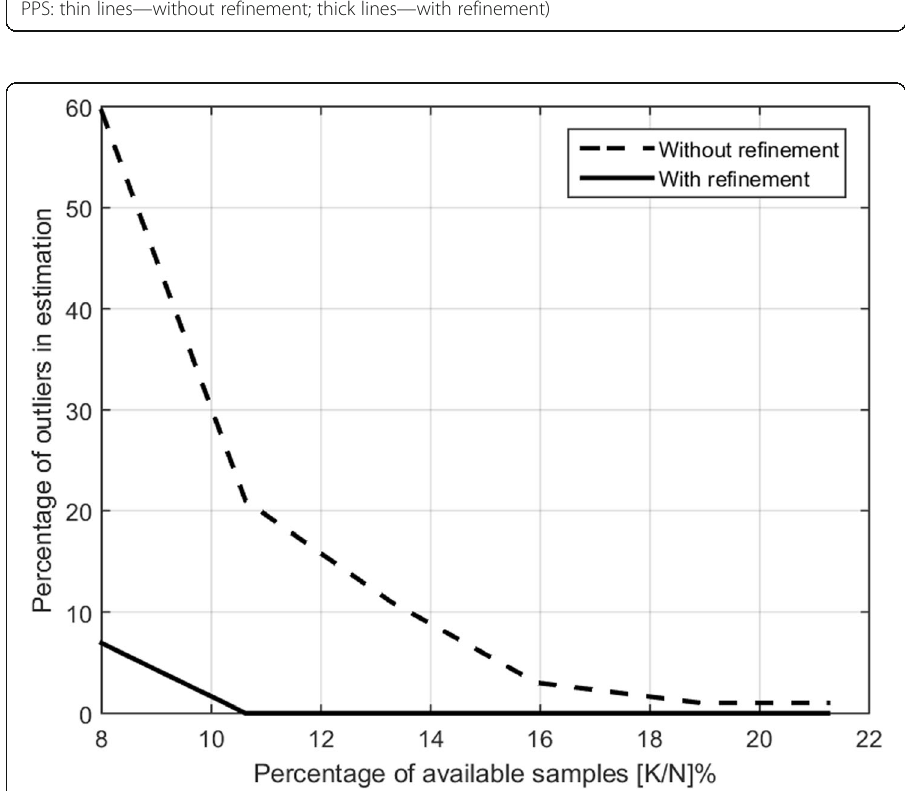
Fig. 8 Percentage of outliers in the IF estimation for the fifth-order PPS: dashed line — without refinement; dashed line — with